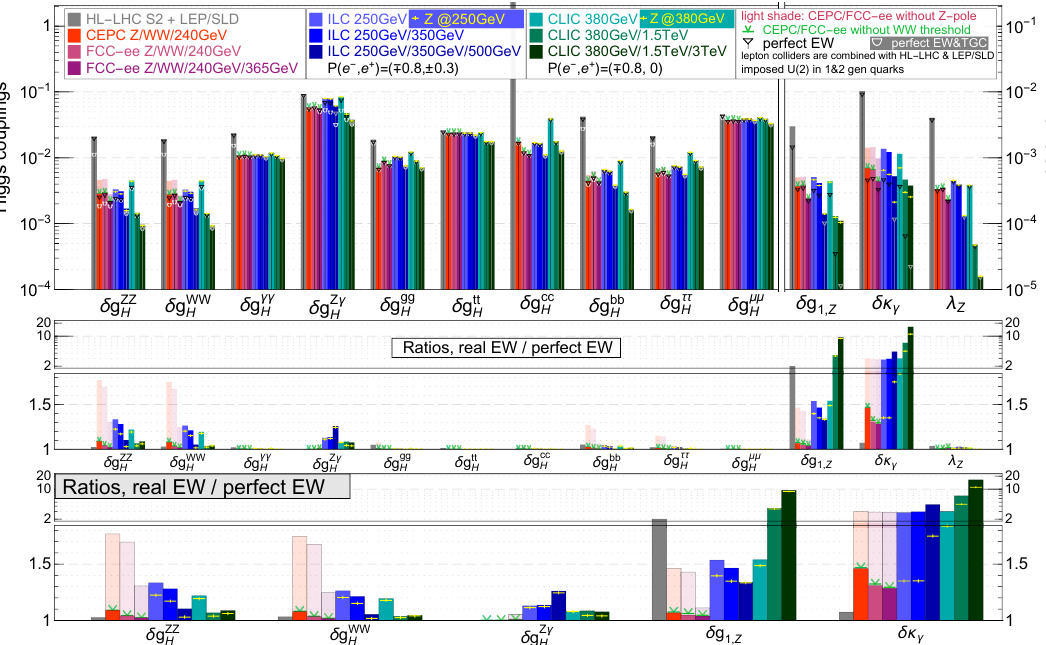
Figure 2 . Global one-sigma reach of future lepton colliders on Higgs and triple-gauge couplings. The run scenarios and luminosities assumed are listed in table 1. LEP and SLD electroweak measurements as well as HL-LHC prospects on Higgs and diboson processes are included in all projections. Modi(cid:12)cations of electroweak parameters (shown in (cid:12)gure 4) are marginalized over to obtain the prospects displayed as bars, and arti(cid:12)cially set to zero to obtain those shown with triangular marks. For the CEPC and FCC-ee, scenarios without the future Z -pole ( WW threshold) run are shown as light shaded bars (lower edges of the green marks). For ILC, the results with the inclusion of the A LR measurement at 250 GeV are shown with yellow marks. The bottom panel highlights the couplings that are a(cid:11)ected signi(cid:12)cantly EW uncertainties. Numerical results are also reported in table